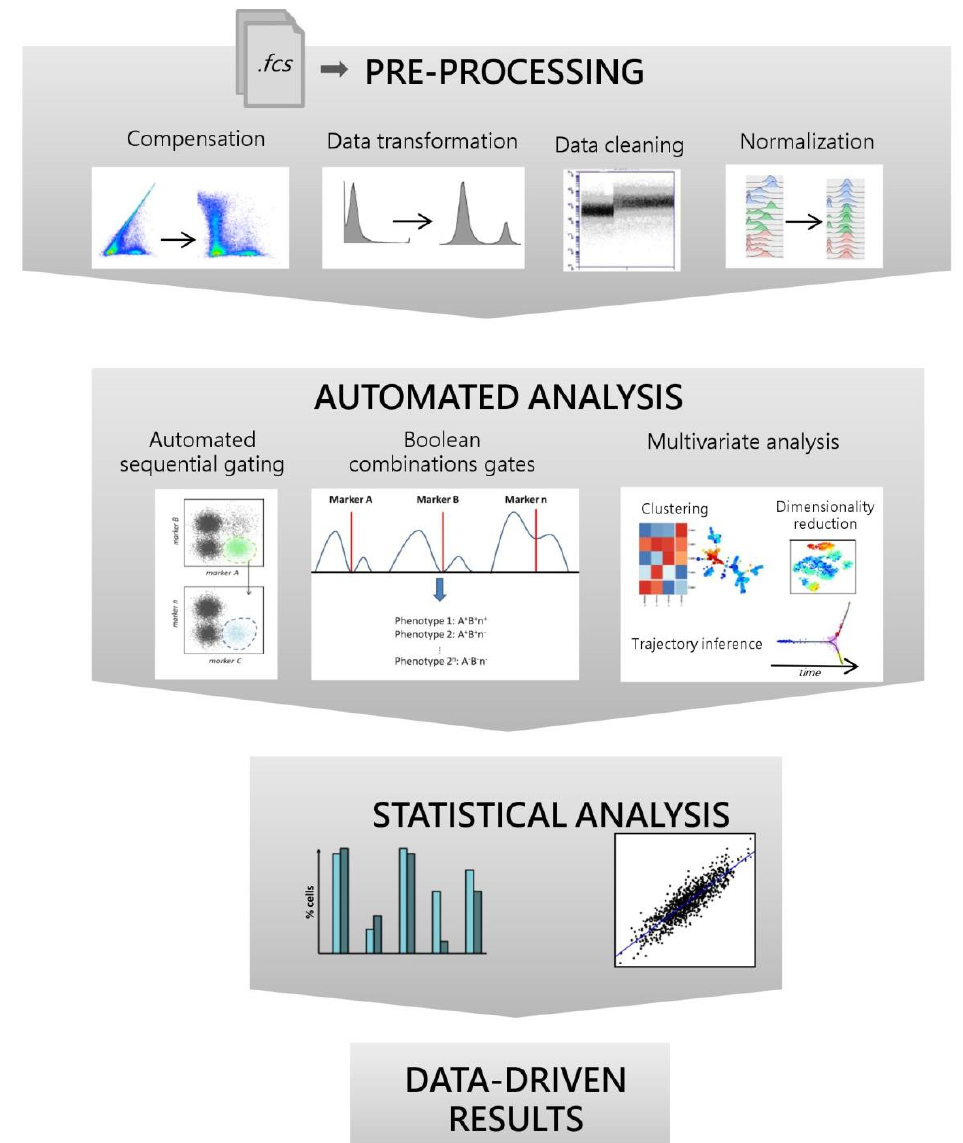
Figure 1. Automated cytometry data analysis workflow. Pipeline of the automated analysis steps of cytometric data. Starting from Flow Cytometry Standard (FCS) files, data are pre-processed to ensure reproducible and reliable results. Pre-processing phases include compensation (spectral overlap correction), data transformation (improvement of cell population visualization and automated cell types identification), data cleaning (removal of dead cells, debris, doublets, etc.), and normalizations (removal of batch e ff ect between samples or balancing the contribution of each marker to